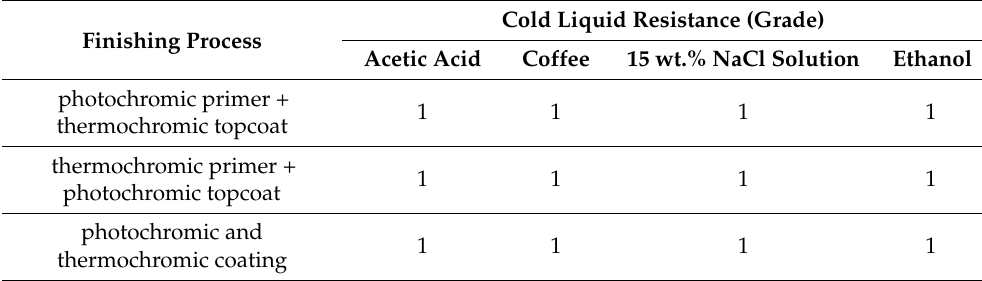
Table 8. Cold liquid resistance grade of the film under different finishing sequences.